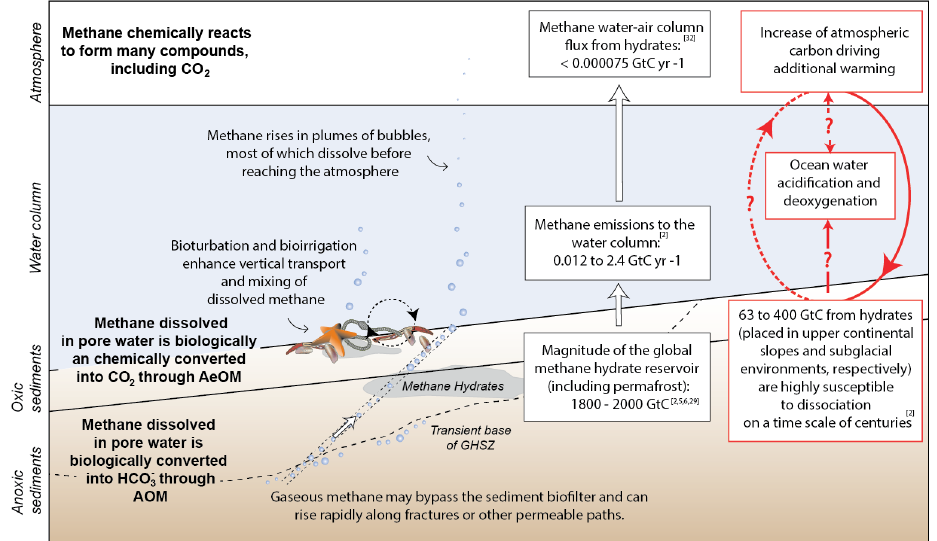
Figure 1. Schematic of hydrate-sourced methane consumption across the sediment-ocean-atmosphere continuum, and potential environmental impacts. Note that red dashed lines indicate the uncertainty of a potential climate feed-back, while the question marks highlight the knowledge gap in quantitative understanding that needs addressing. Some of the published values referenced here have been converted fro m tera-grams (Tg) of methane to GtC (1 Tg of methane = 0.00075 GtC). AeOM: aerobic oxidation of methane; AOM: anaerobic oxidation of methane, GHSZ: gas hydrate stability zone. Adapted from [33]. Data from